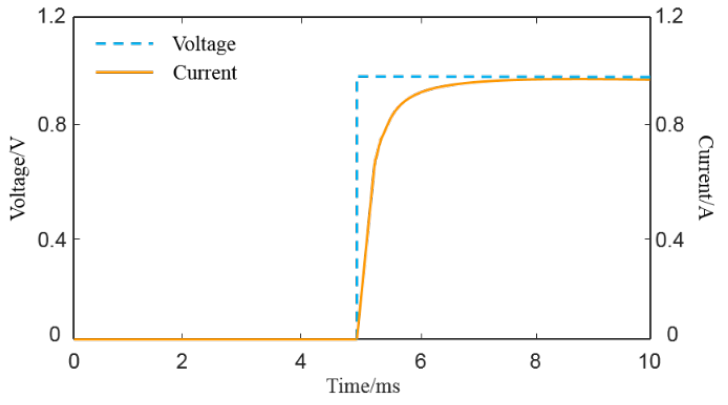
Figure 9. Step response curve of suspended solenoid.